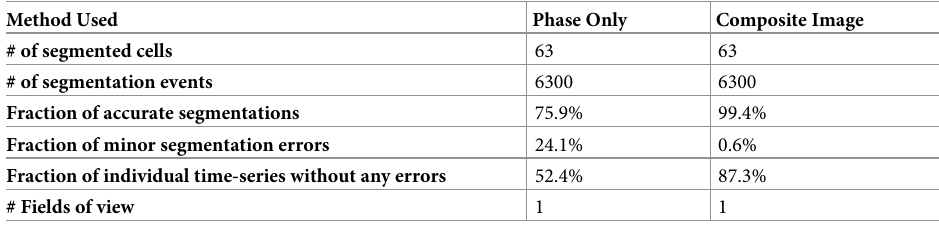
Table 6. Algorithm performance with phase image and the composite